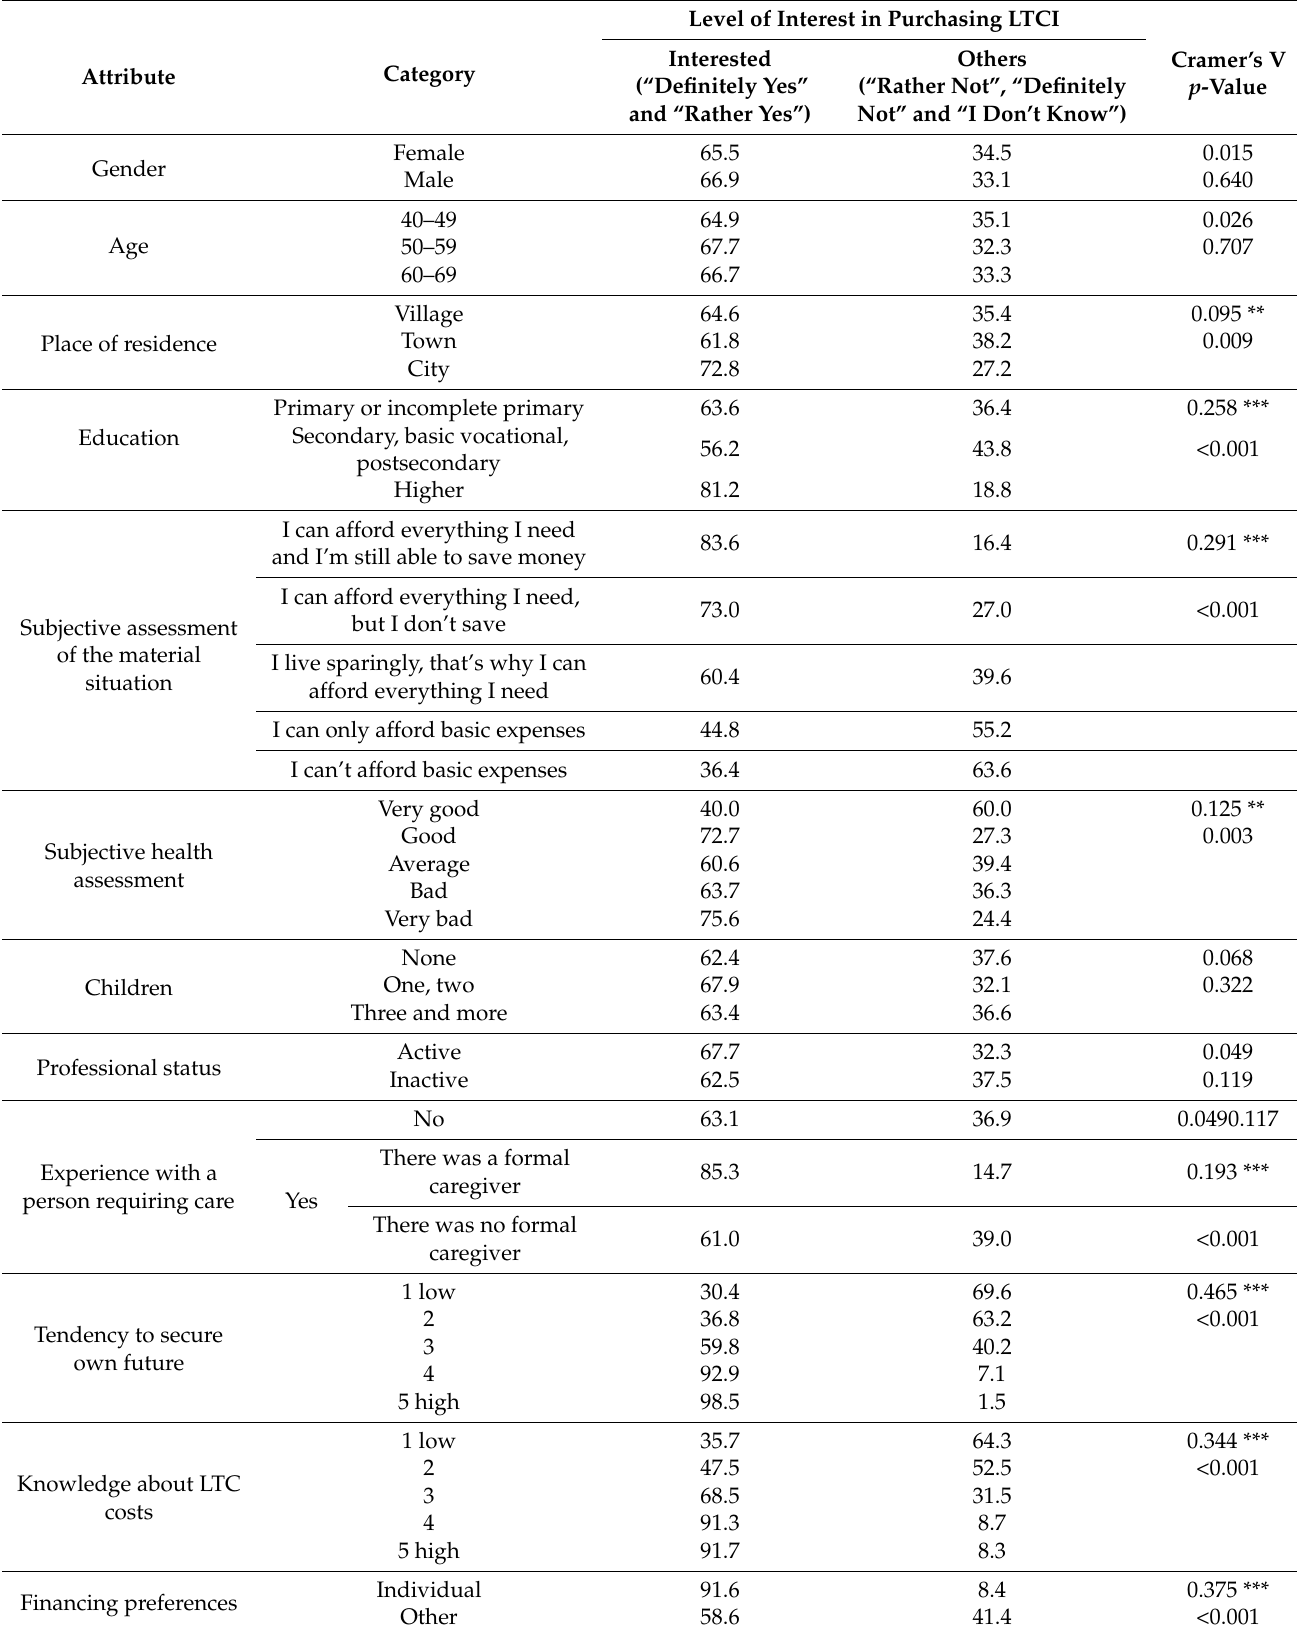
Table 2. Level of interest in purchasing LTCI depending on selected features and measurement of the relationship between them.